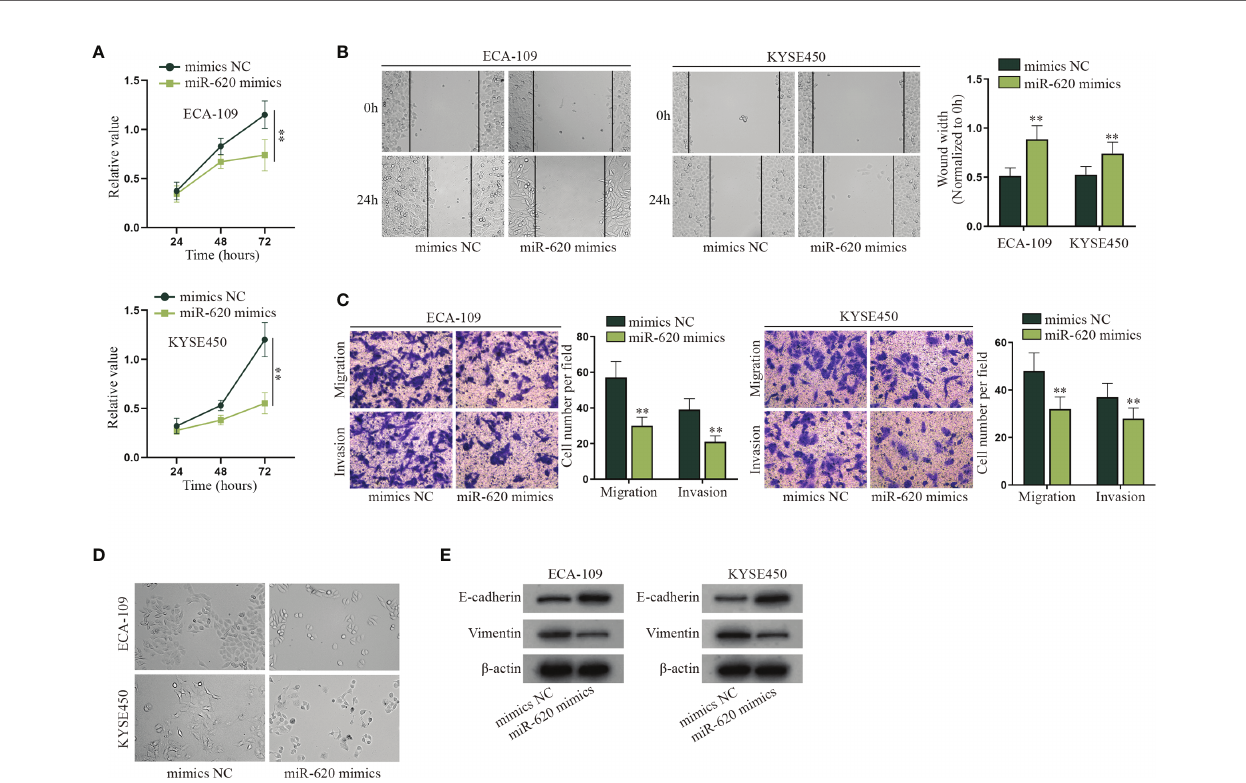
FIGURE 1 | MiR-620 inhibits cell proliferation, migration, invasion, and EMT process in ESCC. (A) CCK-8 assay was taken to detect the proliferative ability of ESCC cells after miR-620 was overexpressed. (B) Wound-healing assay was conducted to detect the migration of the ESCC cells transfected with miR-620 mimics. (C) Transwell assay was carried out to detect the migratory and invasive ability of ESCC cells upon miR-620 overexpression. (D) The phenotype of ESCC cells upon miR-620 overexpression was observed through a microscope. (E) Western blot was utilized to detect the expression of the EMT-related proteins (E-cadherin and Vimentin) upon miR-620 overexpression. ** p <